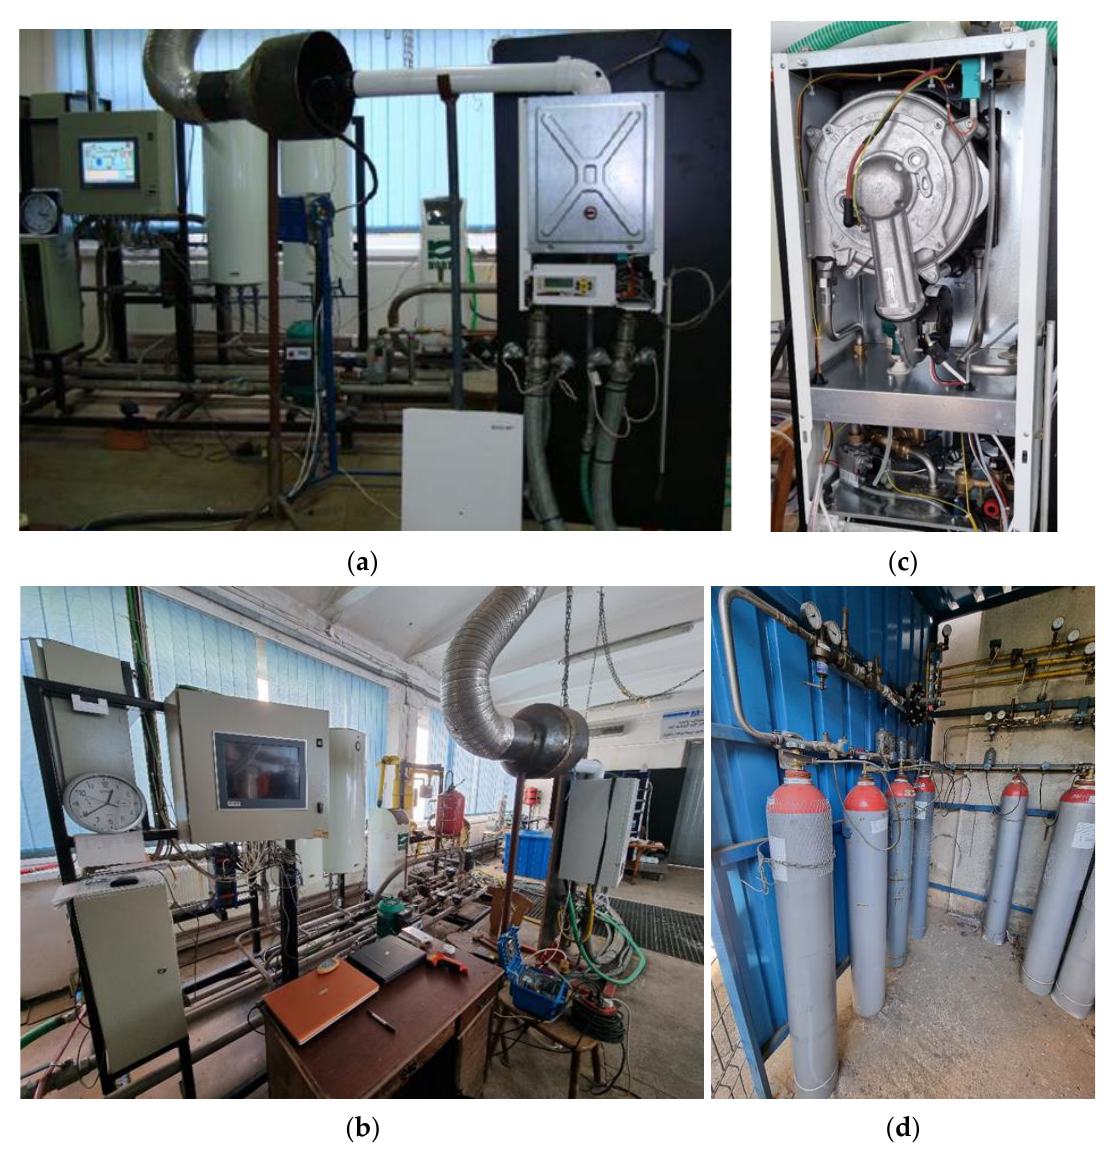
Figure 1. ( a , b ) Experimental stand; ( c ) Flattened pipes boiler, and ( d ) Gas supply plant. The boiler with flattened pipes circuit is schematically presented in Figure 2.